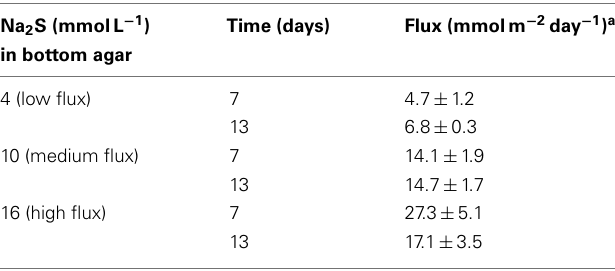
Table 1 | Diffusive sulfide fluxes in gradient cultures from this